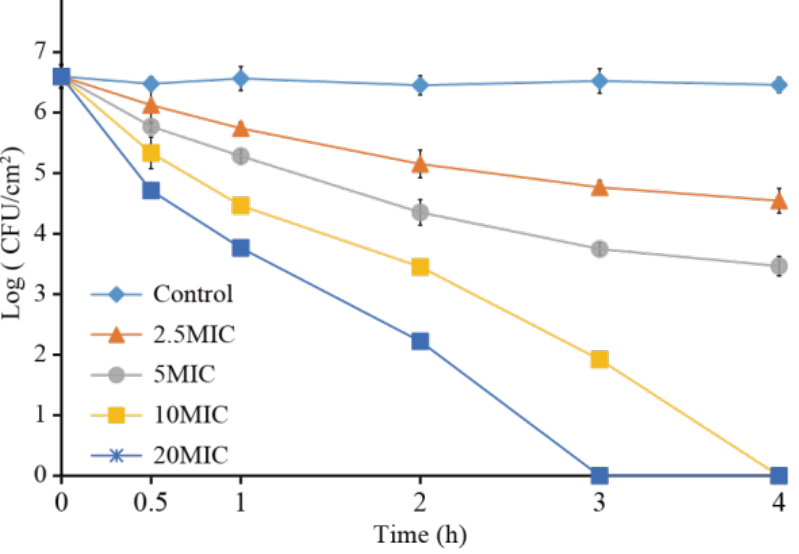
Figure 9. The number of viable C. sakazakii cells in biofilms on stainless steel after LC-EO treatment.